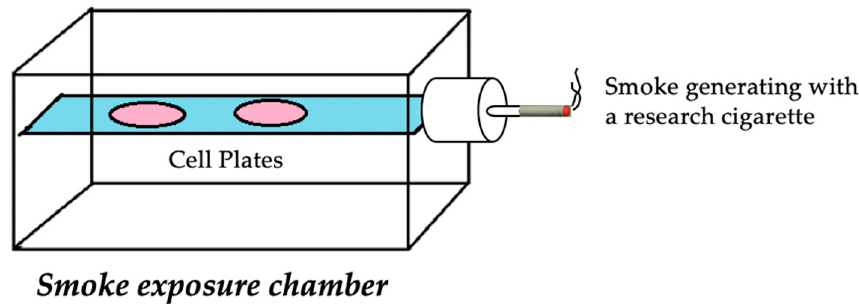
Figure 1. Schematic diagram of chamber apparatus for cigarette-smoke exposure. A549 cells seeded in 6-well plates (pink) with lids off were placed onto the platform (blue) inside a vacuumed-sealed plexiglass container. A fan inside the cylindrical portion propelled the smoke from the University of Kentucky research cigarette (filter removed) into the chamber to induce exposure.